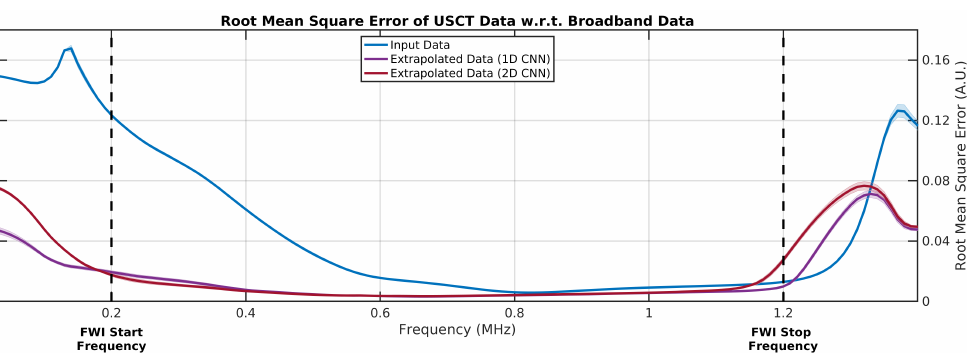
Figure 3. Testing USCT data generated by imaging numerical breast models provided by the OA- Breast database. Each set of 96 traces represents the received signal by the 96 elements of a P4-1 probe at 1 of the positions in the ring array. ( a ) Shot gather simulated using a realistic narrow-band P4-1 source signal and noise; ( b ) shot gather after feeding narrowband signal data into the 1D CNN proposed by Sun et al.; ( c ) shot gather after feeding the narrowband signal data through our U-Net- based 2D CNN; ( d ) shot gather simulated using a ideal broadband source signal without noise.